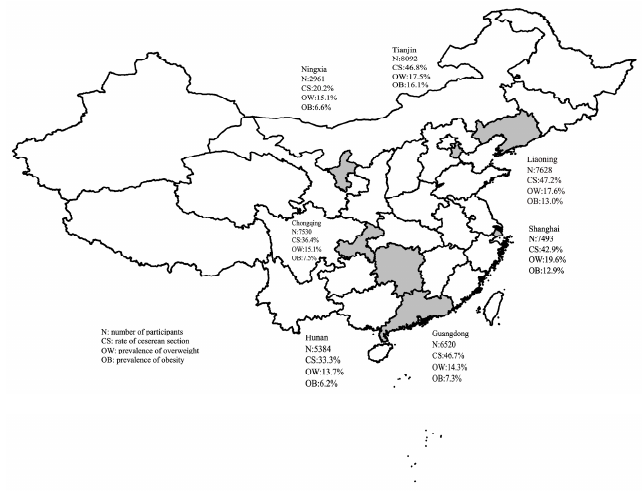
Figure 1. Region-specific distribution of the participants, cesarean section rate and the prevalence of overweight or obesity in China.